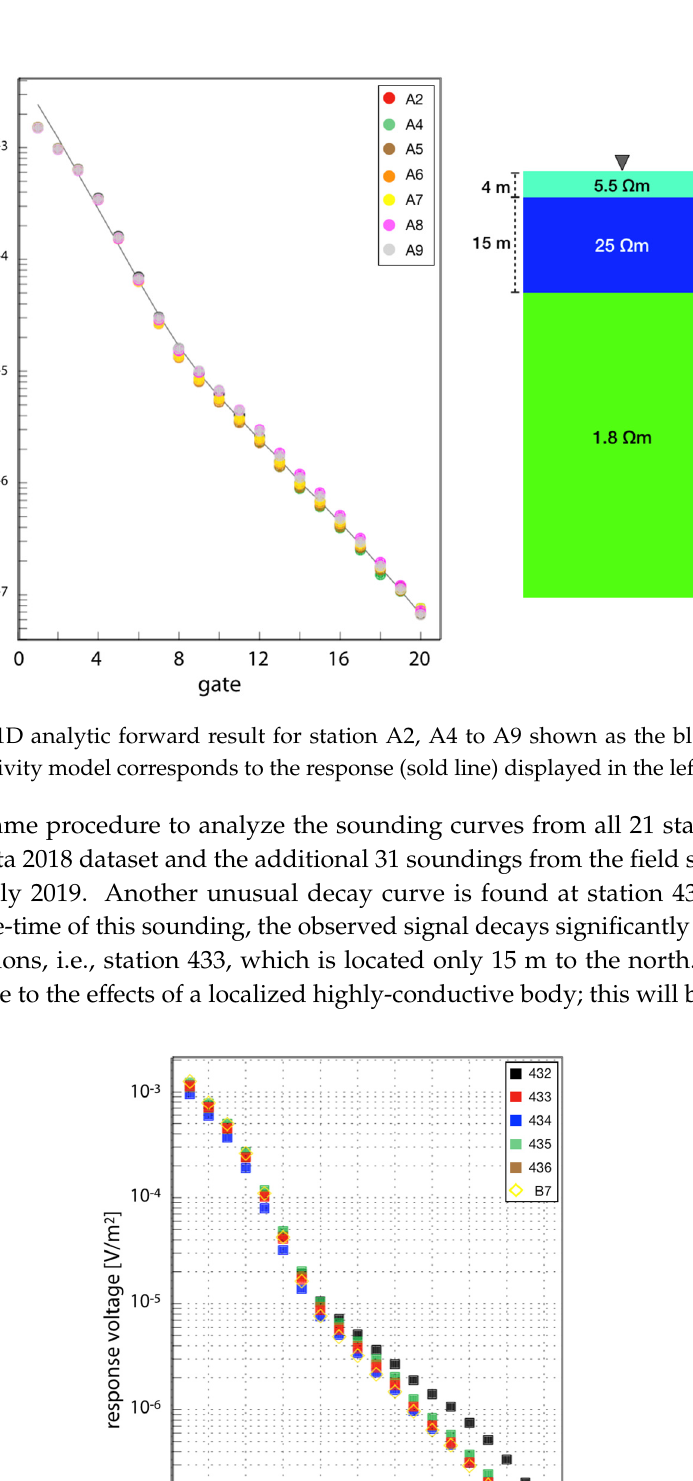
Figure 7. Decay curves of some measured G ‐ TEM soundings at the western section of study area. An unusual decay at station 432 denoted as black squares may be due to a localized highly ‐ conductive body.